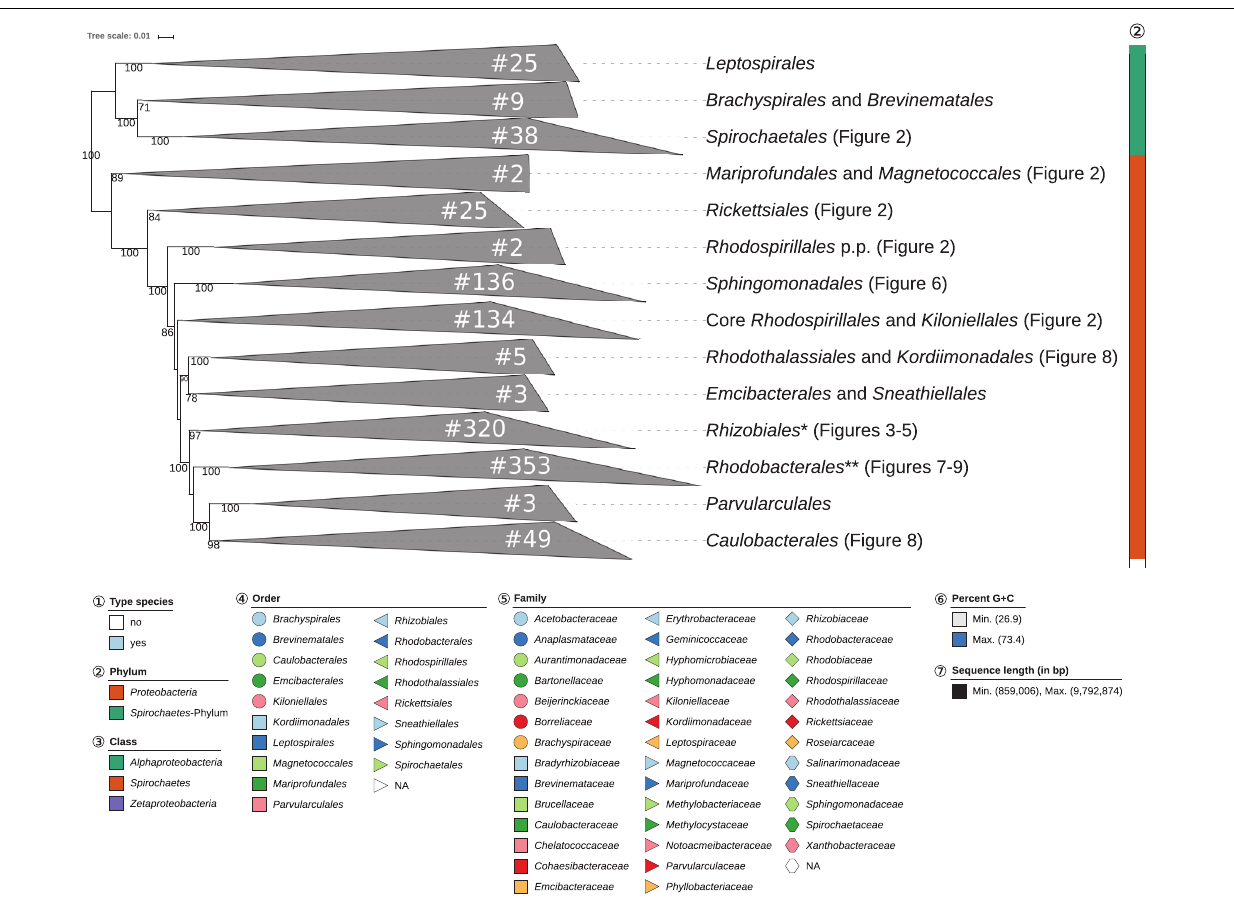
FIGURE 1 | Overview of the phylogenomic tree inferred with FastME from GBDP distances calculated from whole proteomes. The numbers above branches are GBDP pseudo-bootstrap support values from 100 replications. Collapsed clades are displayed as triangles whose side lengths are proportional to the branch-length distances to least and most distant leave, respectively. The total number (#) of leaves per collapsed clade is shown within the triangles. The legend indicates the symbols and colors used in all subsequent figures, which show details of all clades of interest. In Figure 1 itself only the phylum is annotated, while Figures 2 – 9 show specific sections of the same tree in greater detail with the same underlying topology yet some differences in clade ordering. Clades not referred to in the text are not shown in detail in the subsequent figures but are displayed in Supplementary File S2 . *phylogenetically including some taxa placed in Rhodobacterales , ** phylogenetically including some taxa placed in Rhizobiales